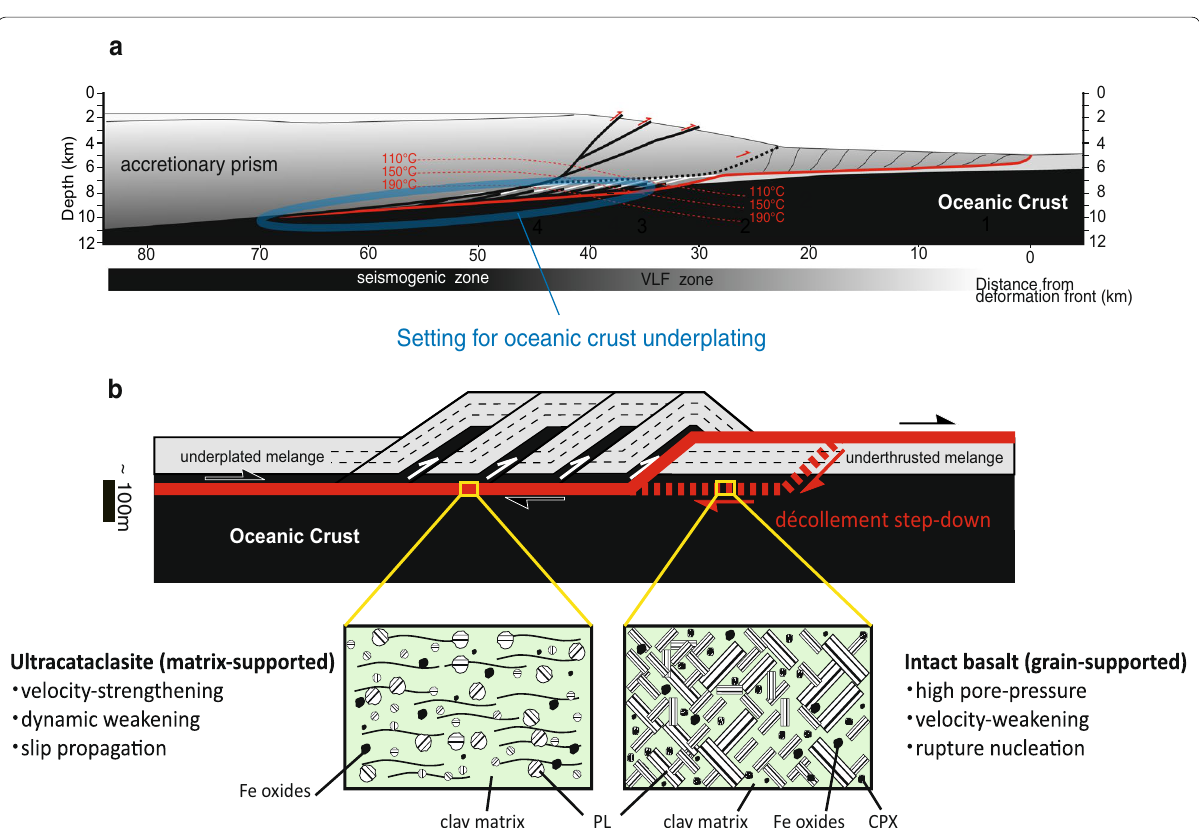
Fig. 8 Model showing a the setting for décollement step-down at the plate interface, and b the textural evolution from intact basalt to mature fault rock (ultracataclasite) as observed in onland exposures. The diagram also shows expected frictional properties and behaviors associated with seismogenesis. Abbreviations are as in Fig.